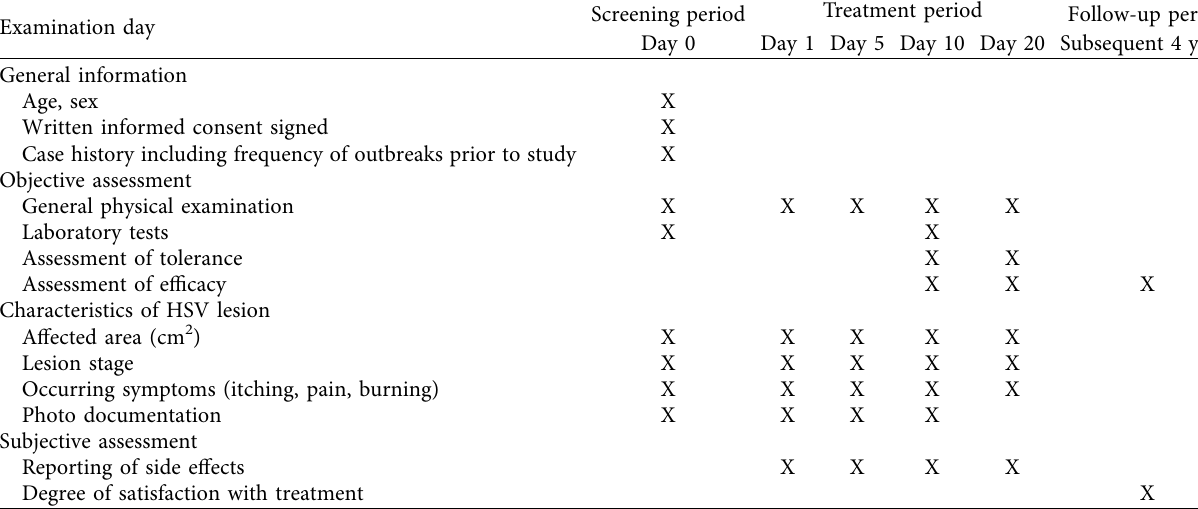
Table 1: Visit schedule and assessed data during the